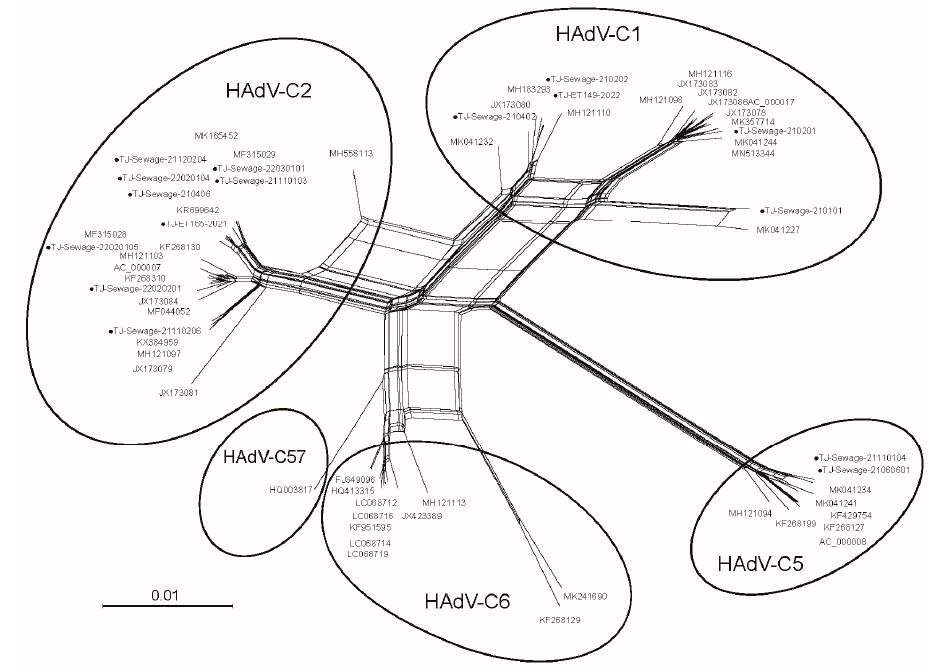
Figure 1. Phylogenetic network built using the complete genomes of 16 Tianjin human adenovirus (HAdV) (represented by black dots) and 52 human adenovirus species C (HAdV-C) strains obtained from the GenBank database.